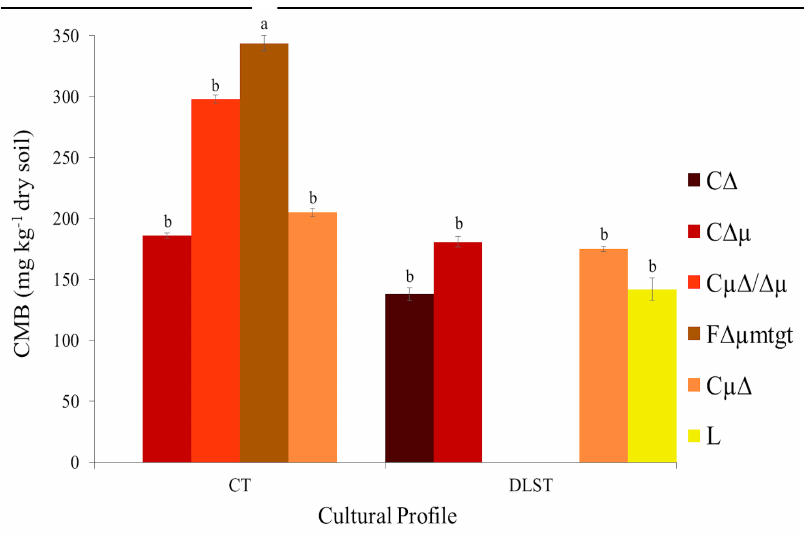
Figure 5. Carbon microbial biomass (CMB) in a dystrophic Red-Yellow Latosol under conventional tillage (CT) and deep localized soil tillage (DLST). Organization of clods: L = free soil volume, C = continuous soil volume, F = cracked soil volume, NAM = unaltered soil volume by use and management, mt = medium clods (7 cm Ø), gt = large clods (10 cm Ø). Internal states of clods: μΔ = porous with indications of compression, μΔ/Δμ = medium porosity, Δμ = compact with some porosity, Δ = compact with no visible porosity to the naked eye. Bars indicate the mean standard error. Volumes of soil with the same letter for different soil tillage systems did not differ statistically in Tukey test (p ≤